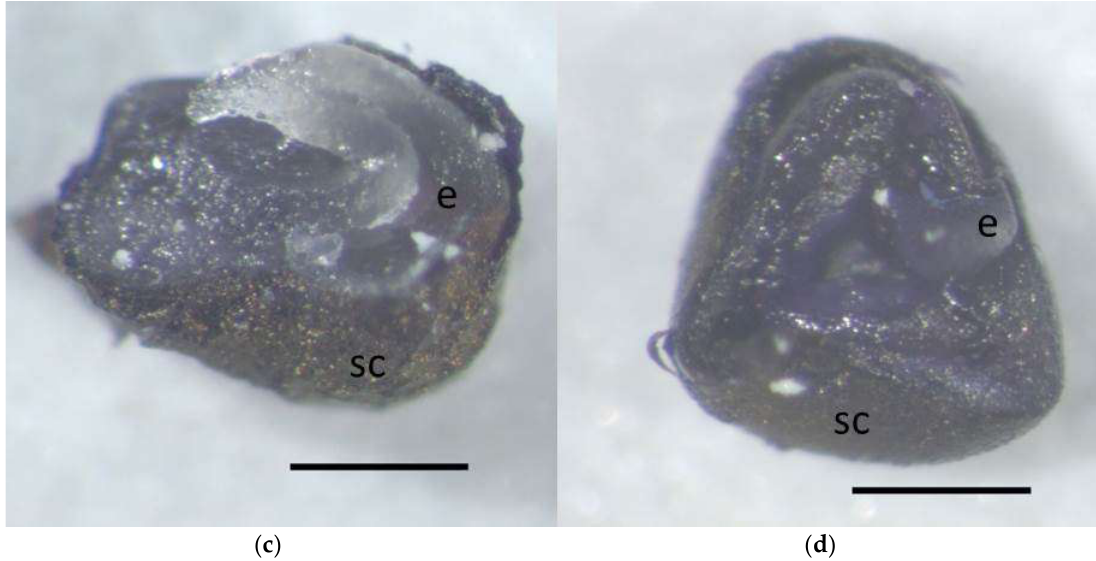
Figure 4. Imbibition and uptake of water and dye by seeds of Cistus ladanifer : photomicrographs ( a ) of dry, nonimbibed seed; ( b ) swollen seed imbibing with water alone for 48 h; ( c ) nonswollen seed imbibed with water solution of methyl violet for 72 h; ( d ) swollen seed imbibed with water solution of methyl violet for 48 h. e , embryo; sc , seed coat. Scale bar = 500 μm.